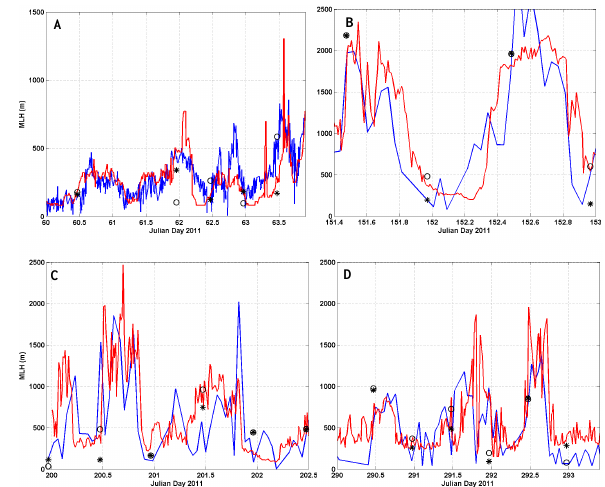
Figure 3: Time series of MLH (in meters above ground level, AGL) estimated from lidar 4 Fig. 3. Time series of MLH (in meters above ground level, a.g.l.) backscatter (red line) and MWR Tb (blue line) observations. Time is expressed in Julian day 5 estimated from lidar backscatter (red line) and MWR Tb (blue line) (day of the year). The four panels indicate March (A), July (B), August (C), and September 6 observations. Time is expressed in Julian day (day of the year). The (D) 2011. The dashed lines at 200 m indicate the lidar full overlap height for the ALS450. 7 four panels indicate March (A) , July (B) , August (C) , and Septem- ber (D) 2011. The dashed lines at 200m indicate the lidar full over- lap height for the ALS450.